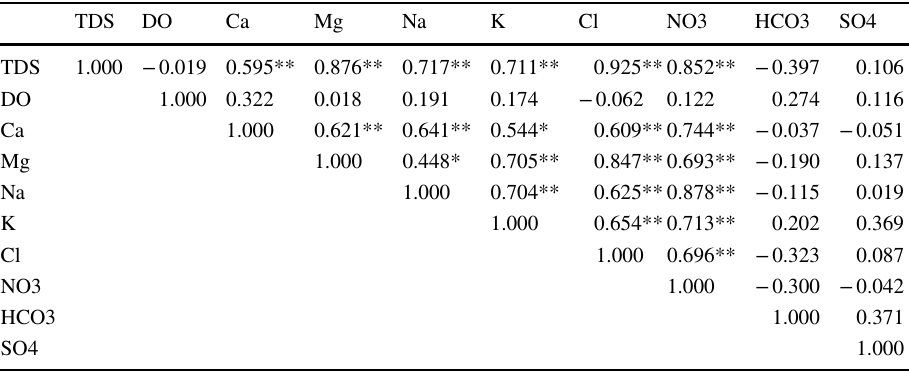
**Correlation is significant at the 0.01 level (2-tailed) *Correlation is significant at the 0.05 level